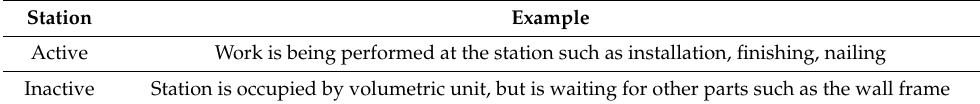
Table 1. Instances where the workstation is active or inactive in modular construction